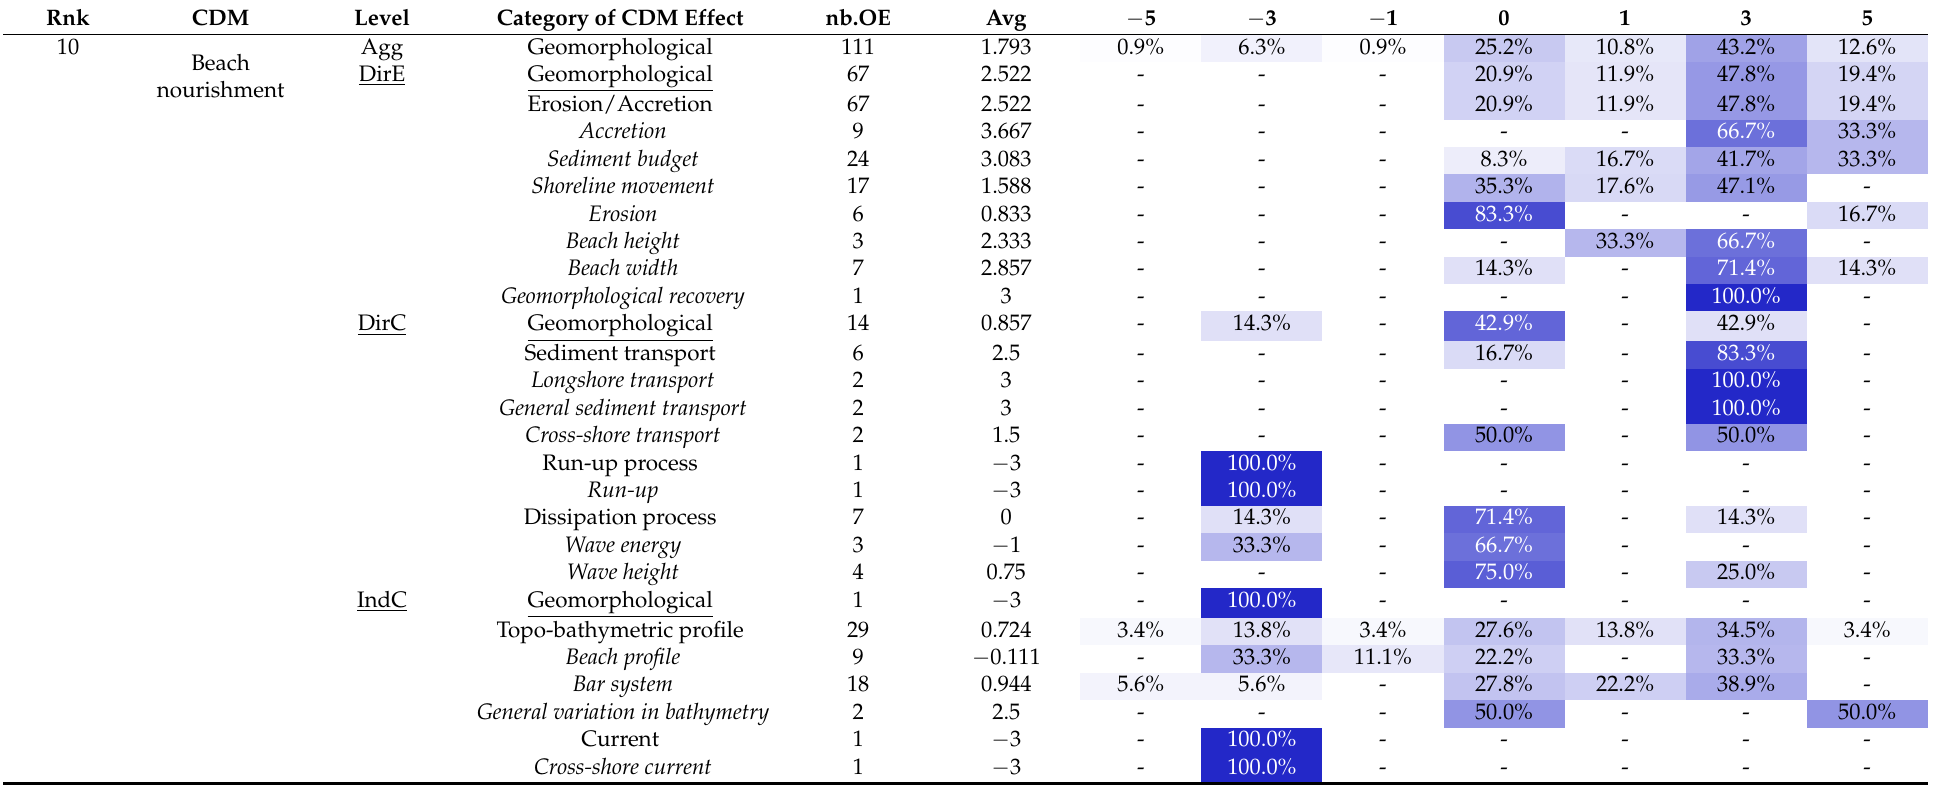
Table 11. Detailed results list of the observed effects of beach nourishment subdivided into geomorphological categories (category, type, subtype ). The results presented, as an example, are in an environmental context described as litoral spit, sand, mesotidal coast, and low energy wave climate (Hs < 1.0 m). The background blue shades is used to give a visual indication of the distribution of the nb.OE on the weighting